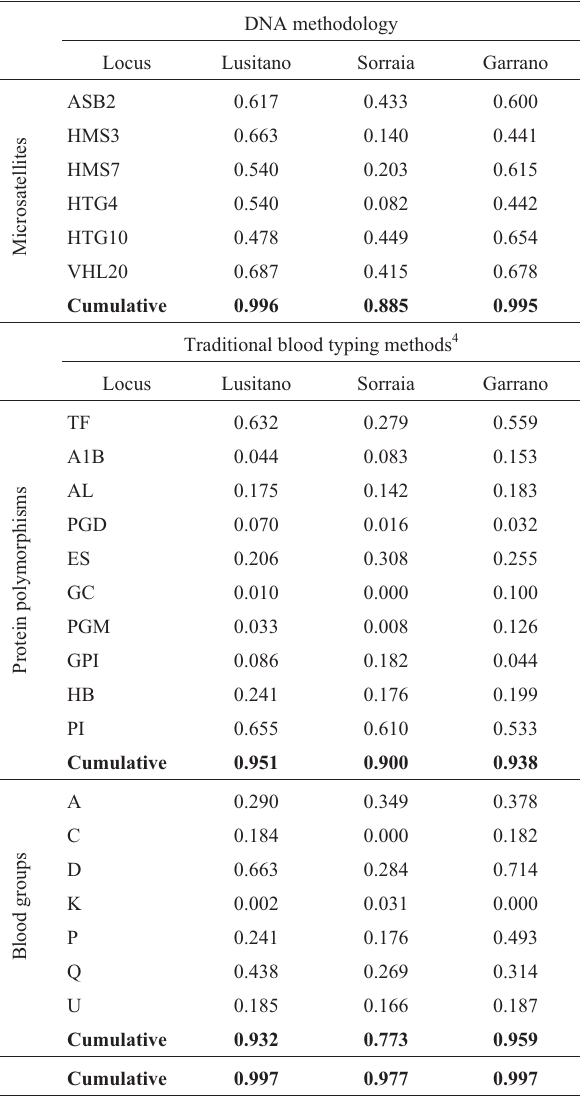
Table II - Individual and cumulative probability of exclusion values for the three horse breeds (Lusitano, Garrano, Sorraia) based on DNA methodology (6 microssatellites) and traditional blood typing methods (10 protein polymorphisms and 7 blood